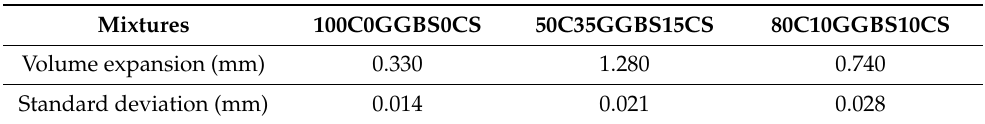
Table 9. Mixture expansion